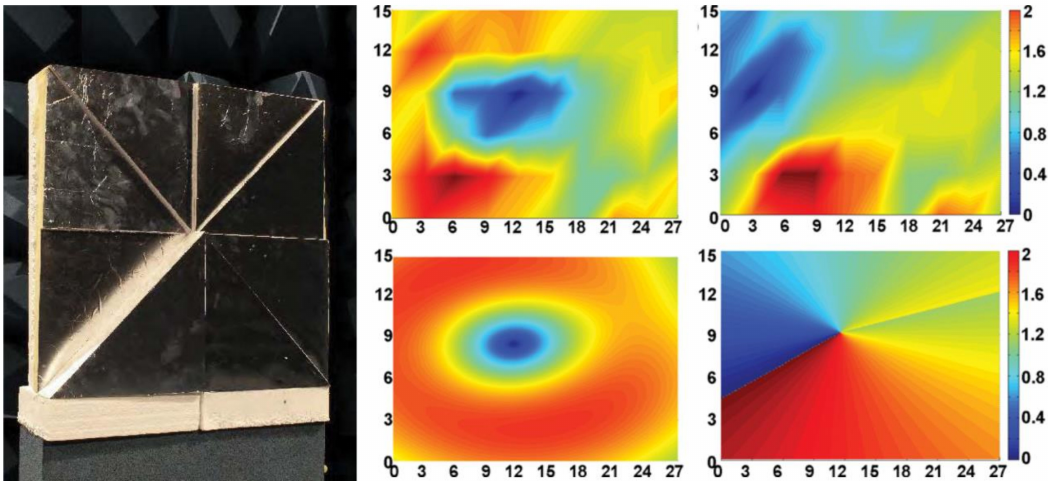
Figure 4. Photography of the spiral reflector and the near electric-field intensity and phase patterns measured (top) and simulated (bottom) at 2.4 GHz [32].